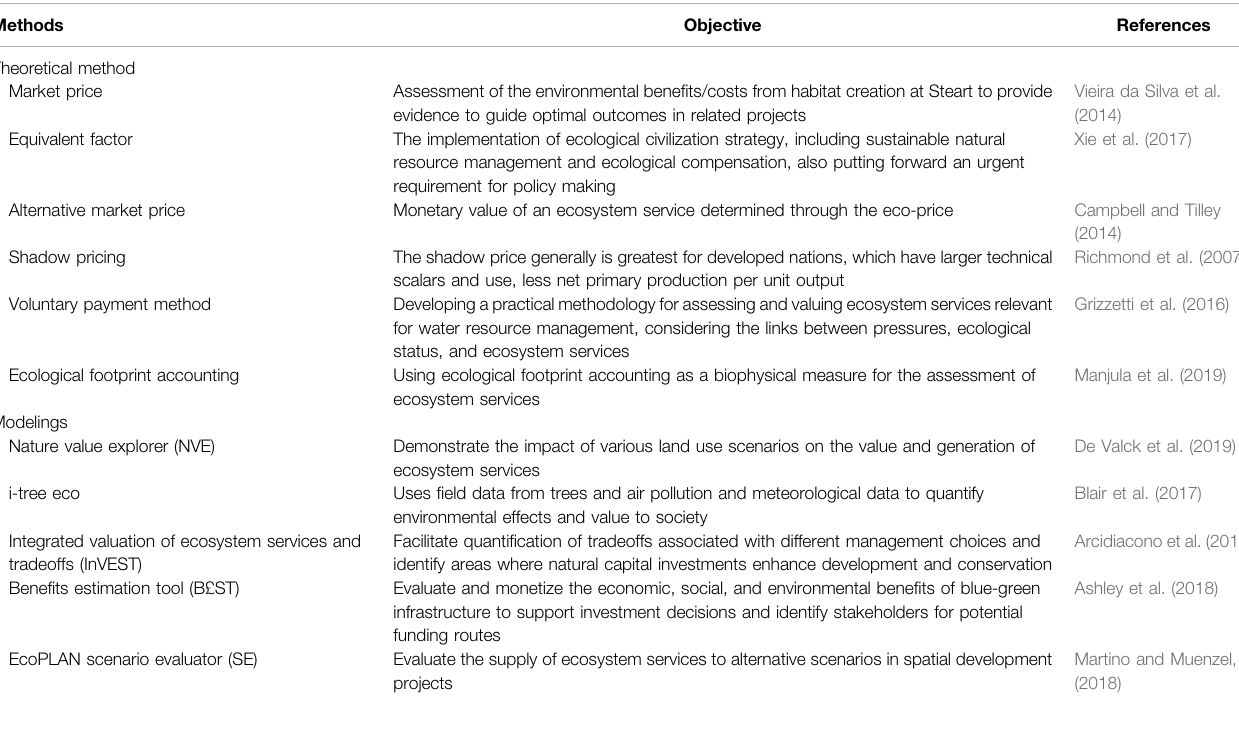
TABLE 1 | Shortlist of methods for quantifying the value of eco-products.